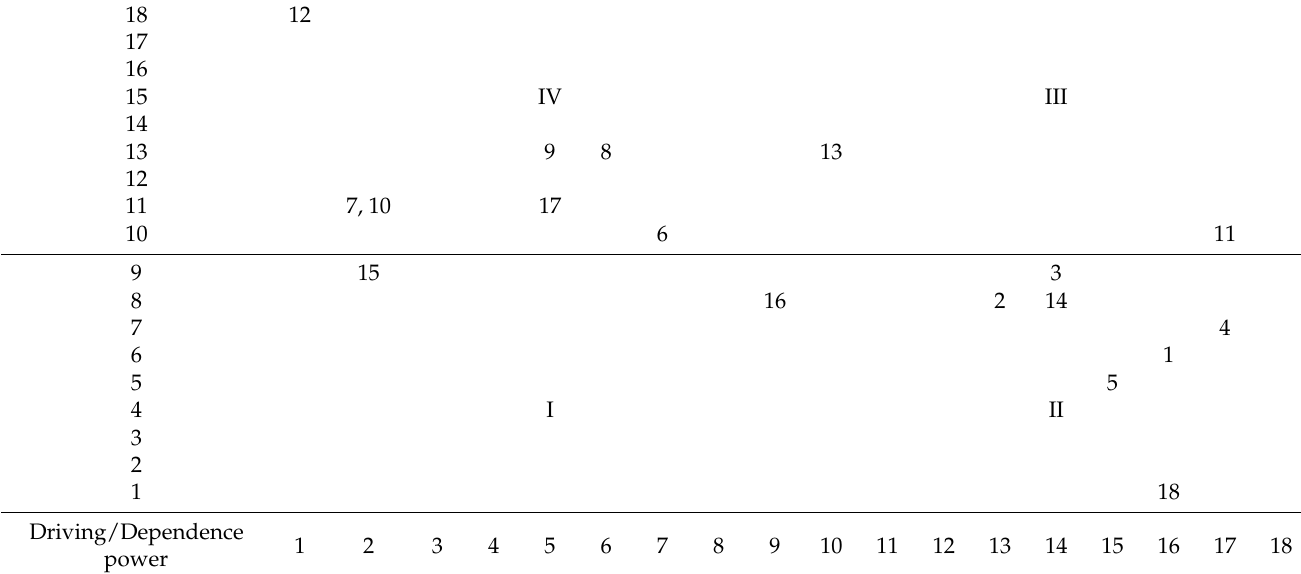
Table 15. Clusters of uncertainty and risk factors in logistics service